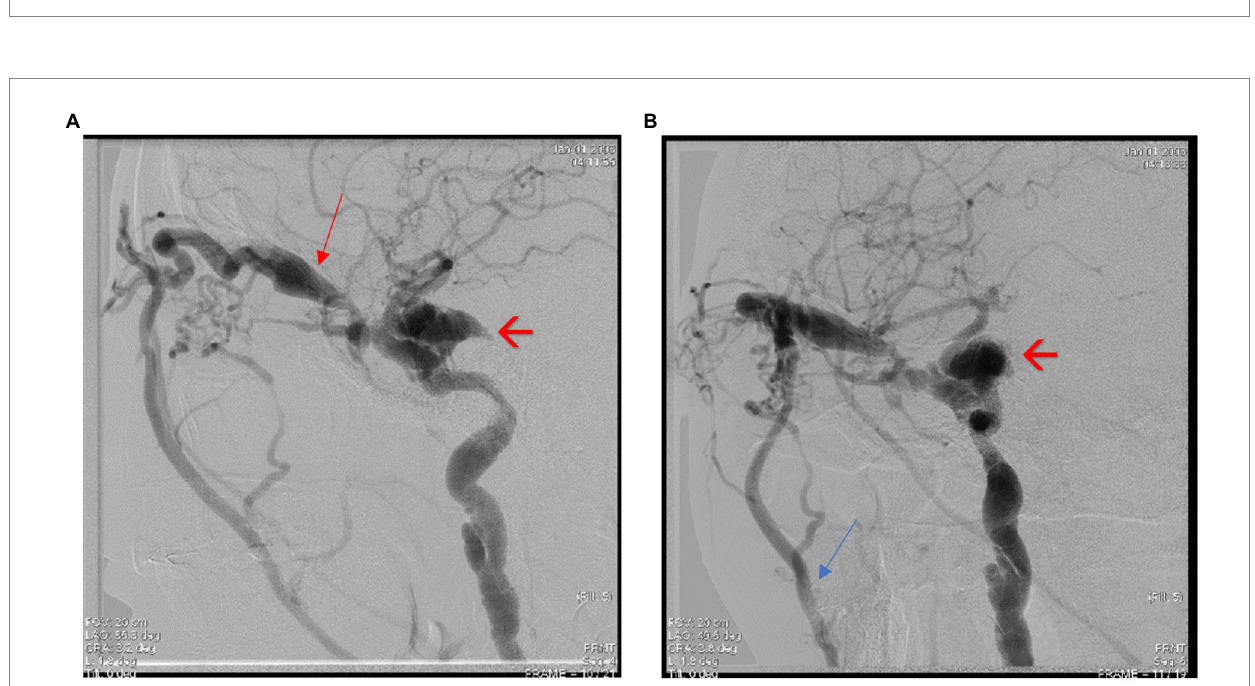
FIGURE 6 (A,B) Cerebral angiography highlighting the direct carotid-cavernous fistula (Type D). Notice the dilated superior ophthalmic vein – see red arrow, and the shunts between ECA and ICA and the facial vein – see blue arrow.